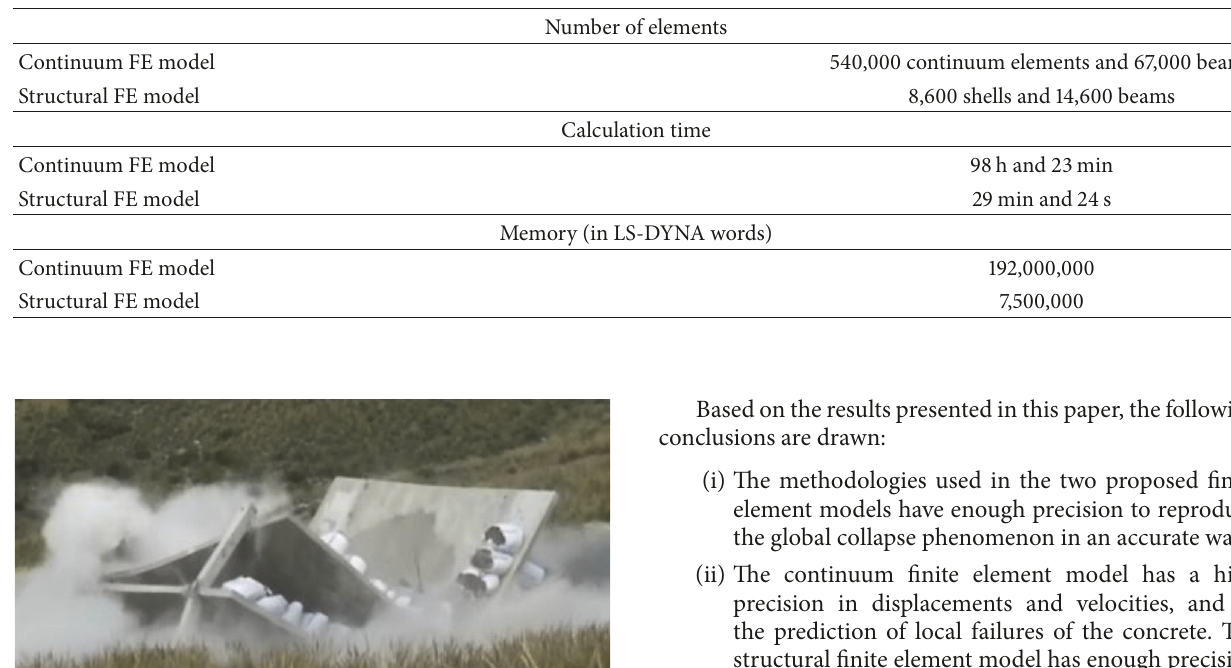
Table 5: Computational cost comparison between continuum FE model and structural FE model for four parallel processors Intel(R) Core(TM) i7-2600 CPU @ 3.40 GHz.